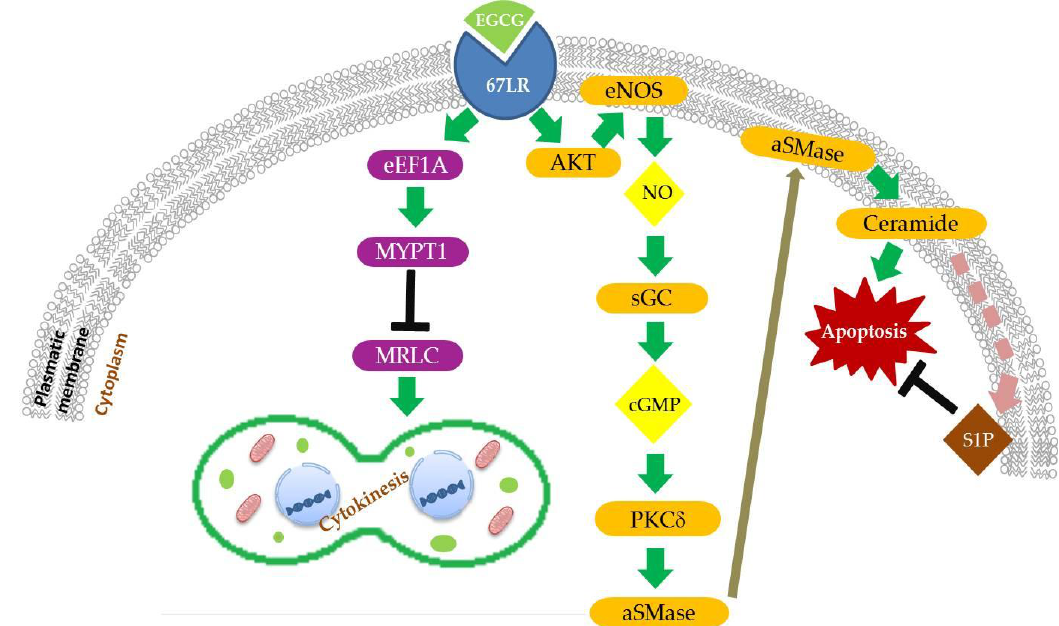
Figure 1. EGCG modulates cell division and apoptosis via 67LR. EGCG binding to 67-kDa laminin receptor (67LR) activates apoptosis program through enhanced nitric oxide (NO) and cGMP production, acid sphingomyelinase ( α SMase) activation and ceramide generation. Ceramide metabolization in sphingosine-1-phosphate (S1P) reduces cell apoptosis. EGCG binding to 67LR inhibits via eukaryotic translation elongation factor 1a (eEF1A) cell cytokinesis inducing myosin phosphatase target subunit (MYPT1) dephosphorylation and activation and myosin II regulatory light chain